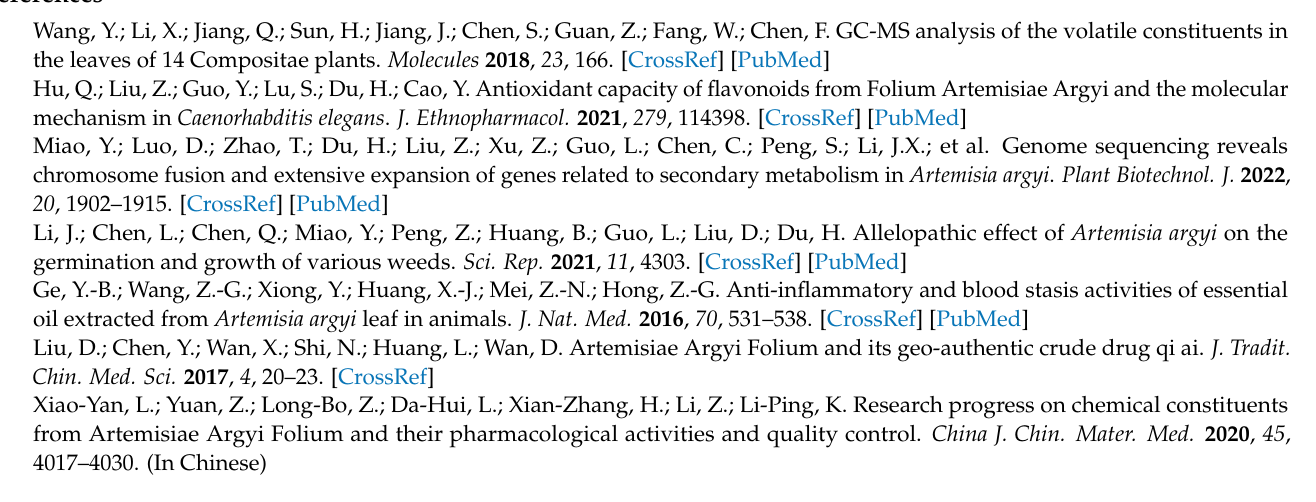
Table S2: The linear relationship of 8 bioactive